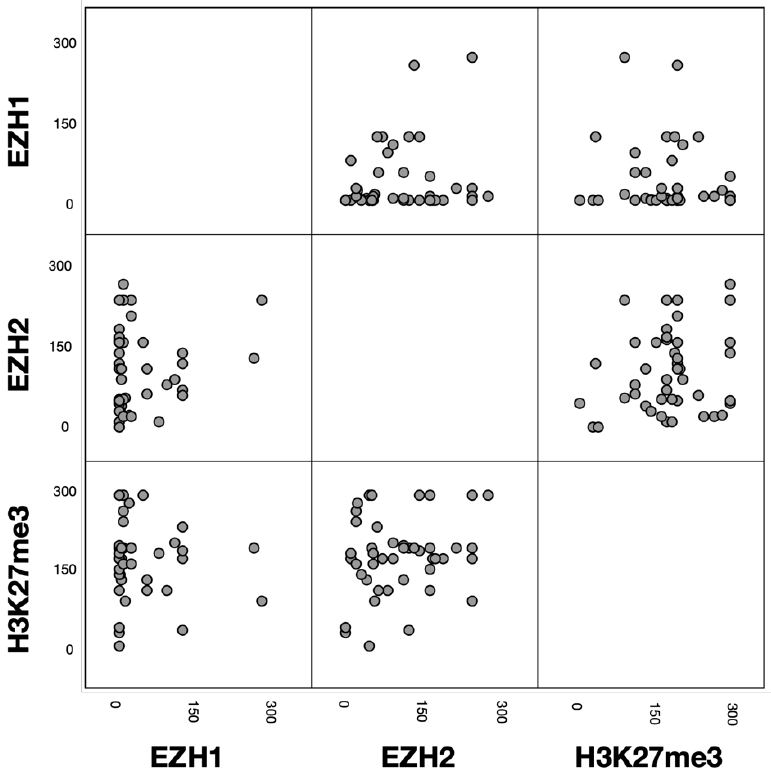
Figure 4. Scatterplot matrix visualizing the associations between EZH1, EZH2, and H3K27me3 immunohistochemical protein expression (H-score).